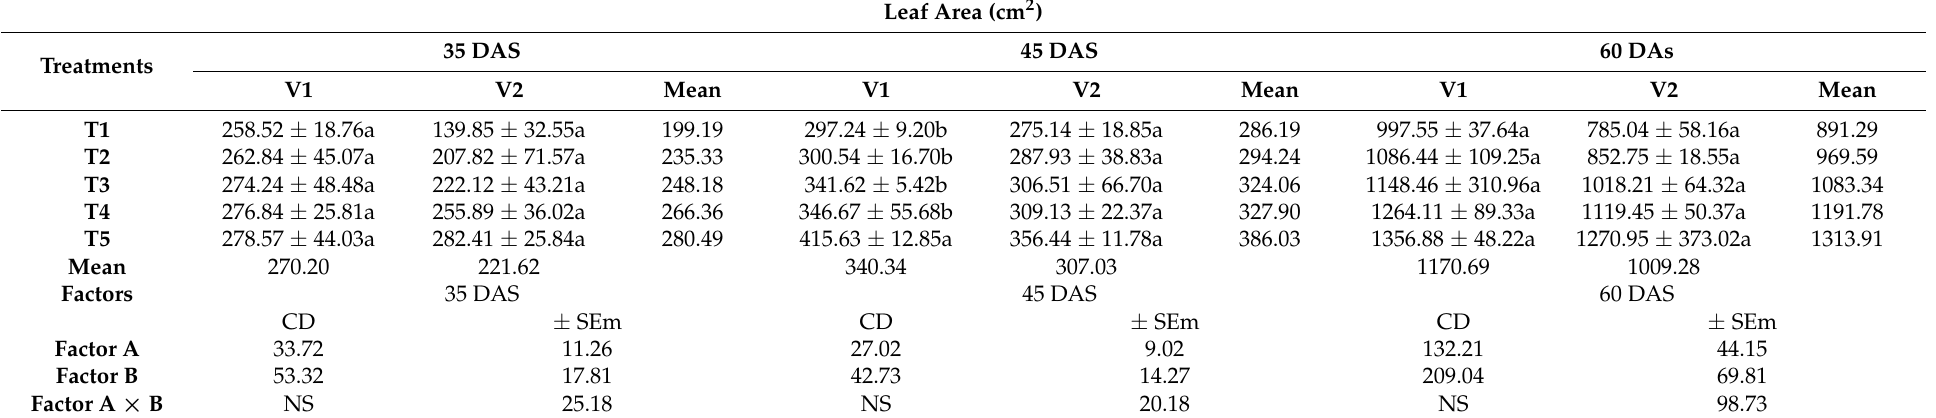
Table 5. Effect of hydro, Mg(NO 3 ) 2 , ZnSO 4 , Mg(NO 3 ) 2 + ZnSO 4 primed, and nonprimed (control) seed treatments on leaf Area (cm 2 ) of wheat varieties, grown in the year